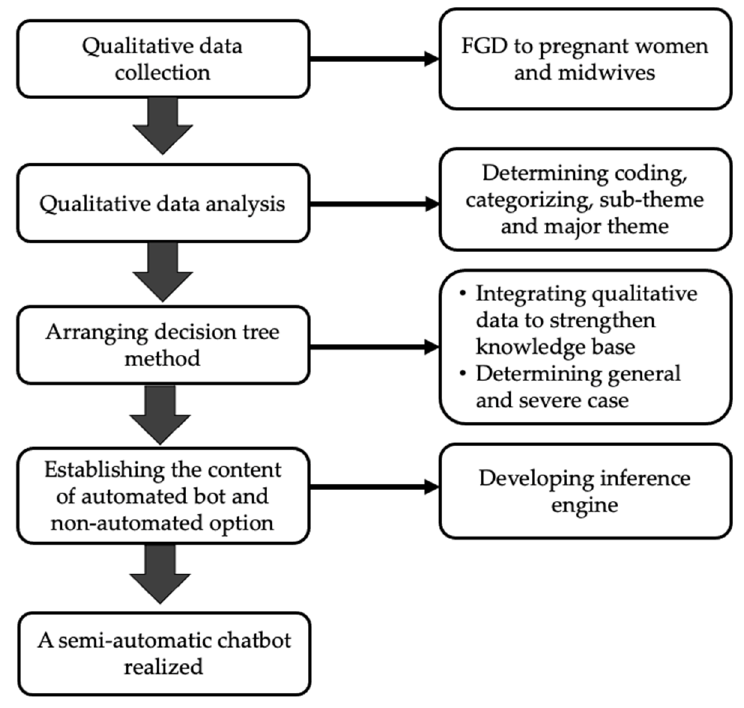
Figure 1. Stages of the research process.